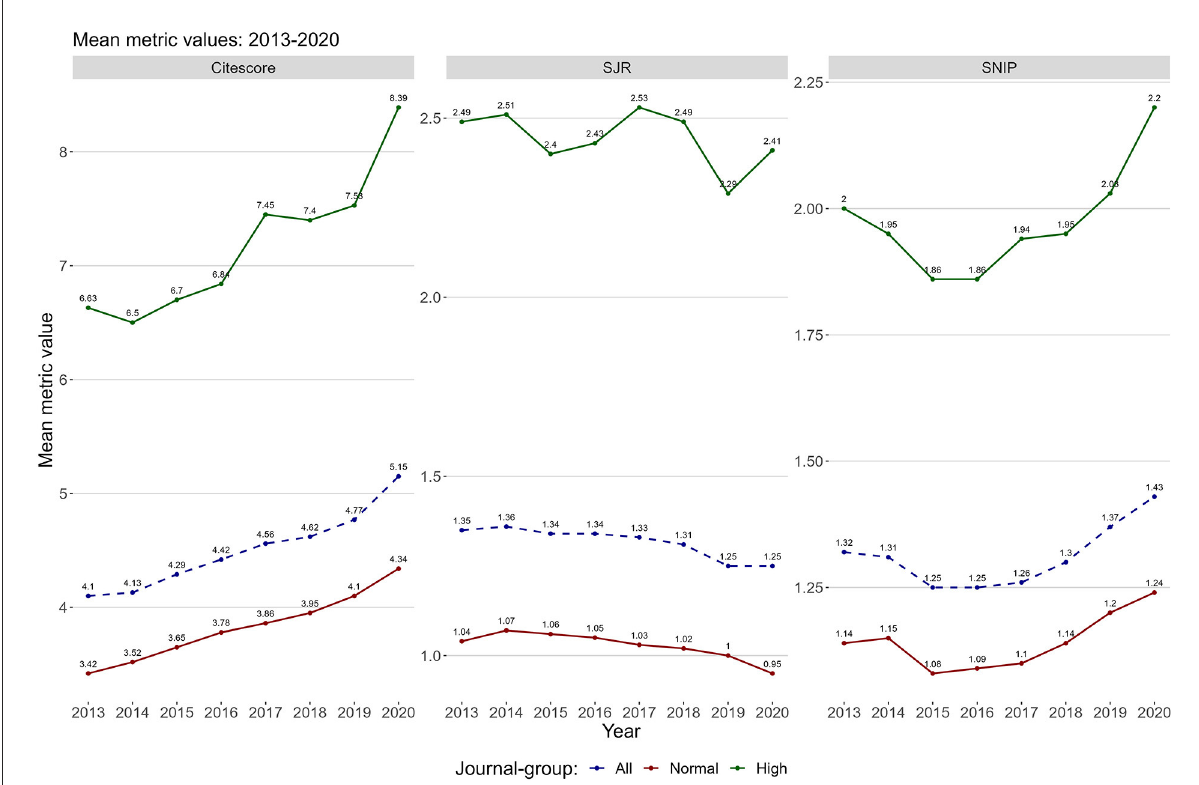
FIGURE4 The yearly mean SJR, SNIP, and CiteScore value in the period 2013–2020 for journals with at least one publication in the period 2013–2020 ( n = 16,056). The journals are grouped by their assignment on the normal level (red line) or on the high level (green line). The dashed blue line represents the mean value for all journals irrespective of level